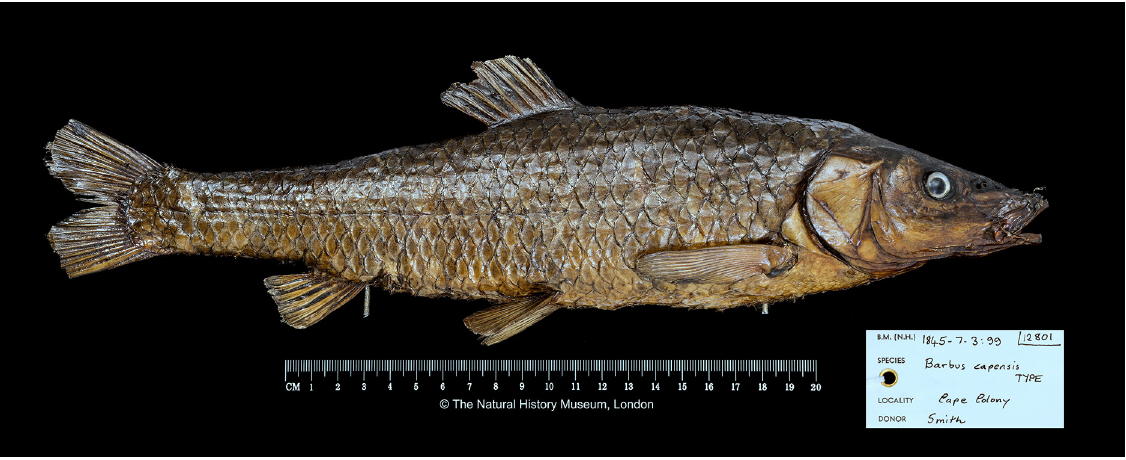
Fig. 1. The type (lectotype) of Barbus (Cheilobarbus) capensis Smith, 1841 (NHMUK 1845.7.3.99). Photograph credit: Trustees of the Natural History Museum,